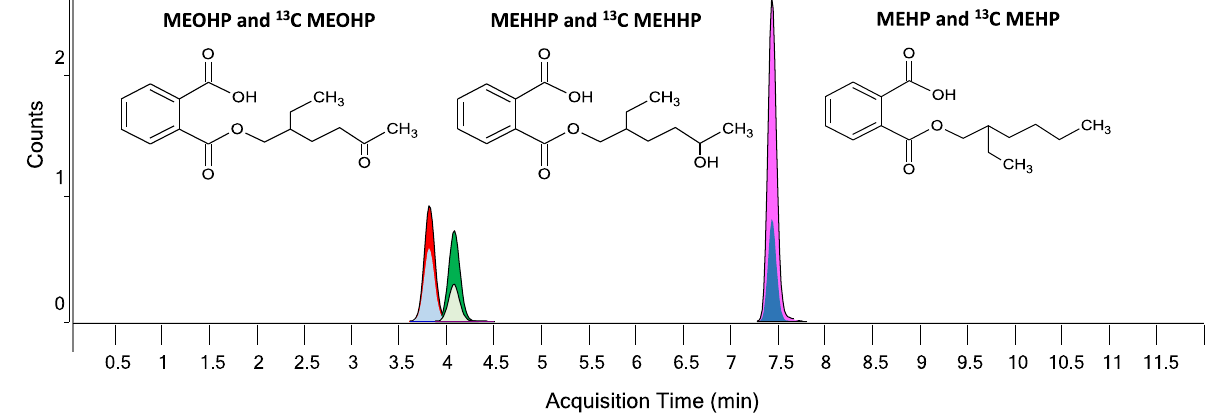
Figure 3. Peak extraction of standards of phthalate metabolites (MEOHP, MEHHP, and MEHP) and their 13 C labeled standard by UHPLC/QTOF.